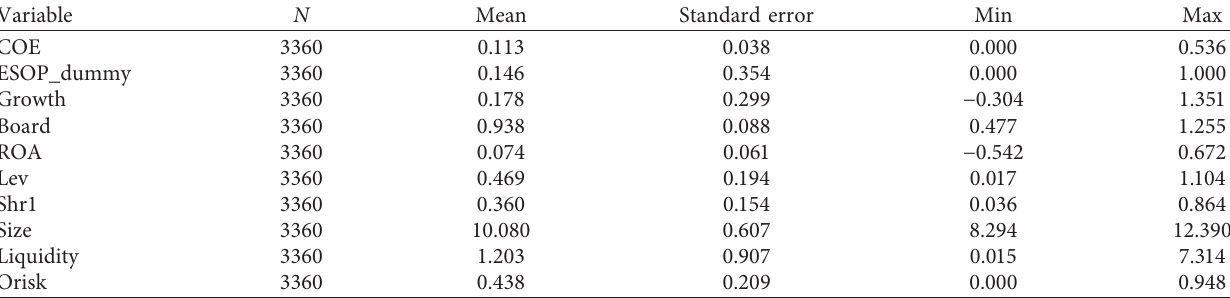
Table 1: Descriptive statistics of research variables for the full sample.